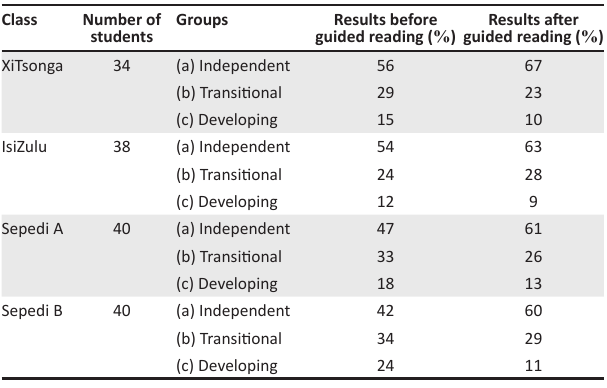
TABLE 1: Observation results